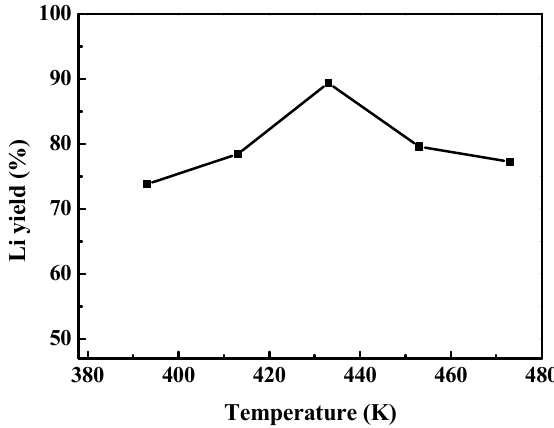
Figure 6. Effect of leaching temperature on the extraction of lithium.